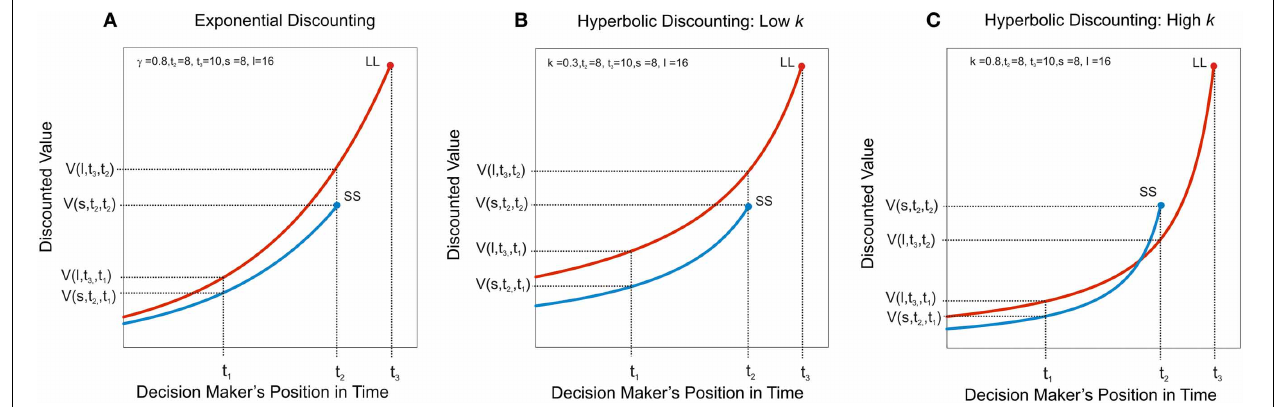
FIGURE 1 | Hyperbolic discounting predicts myopic preference reversal. Discounted value , V ( A , t , τ ) under three discount functions is plotted of as a function of the decision maker’s position in time, τ , where A is the magnitude of the outcome (its instantaneous utility) and t the time at which it is due to be delivered. A larger-later reward, LL, of magnitude, l , is due to be received at t 3 and a smaller-sooner reward, SS, of magnitude, s , is due to be received at t 2 . (A) Exponential discounting. The decision-maker has consistent preferences, such that the ratio of the value of two rewards is constant irrespective of how far away the options are in time; in this case the decision-maker always prefers the larger later (cid:4) (cid:3) > V ( s , t 2 , τ ) for all τ < t 3 ). (B) Hyperbolic reward (i.e., V l , t 3 , τ discounting with a low discount rate. The ratio of the value of two